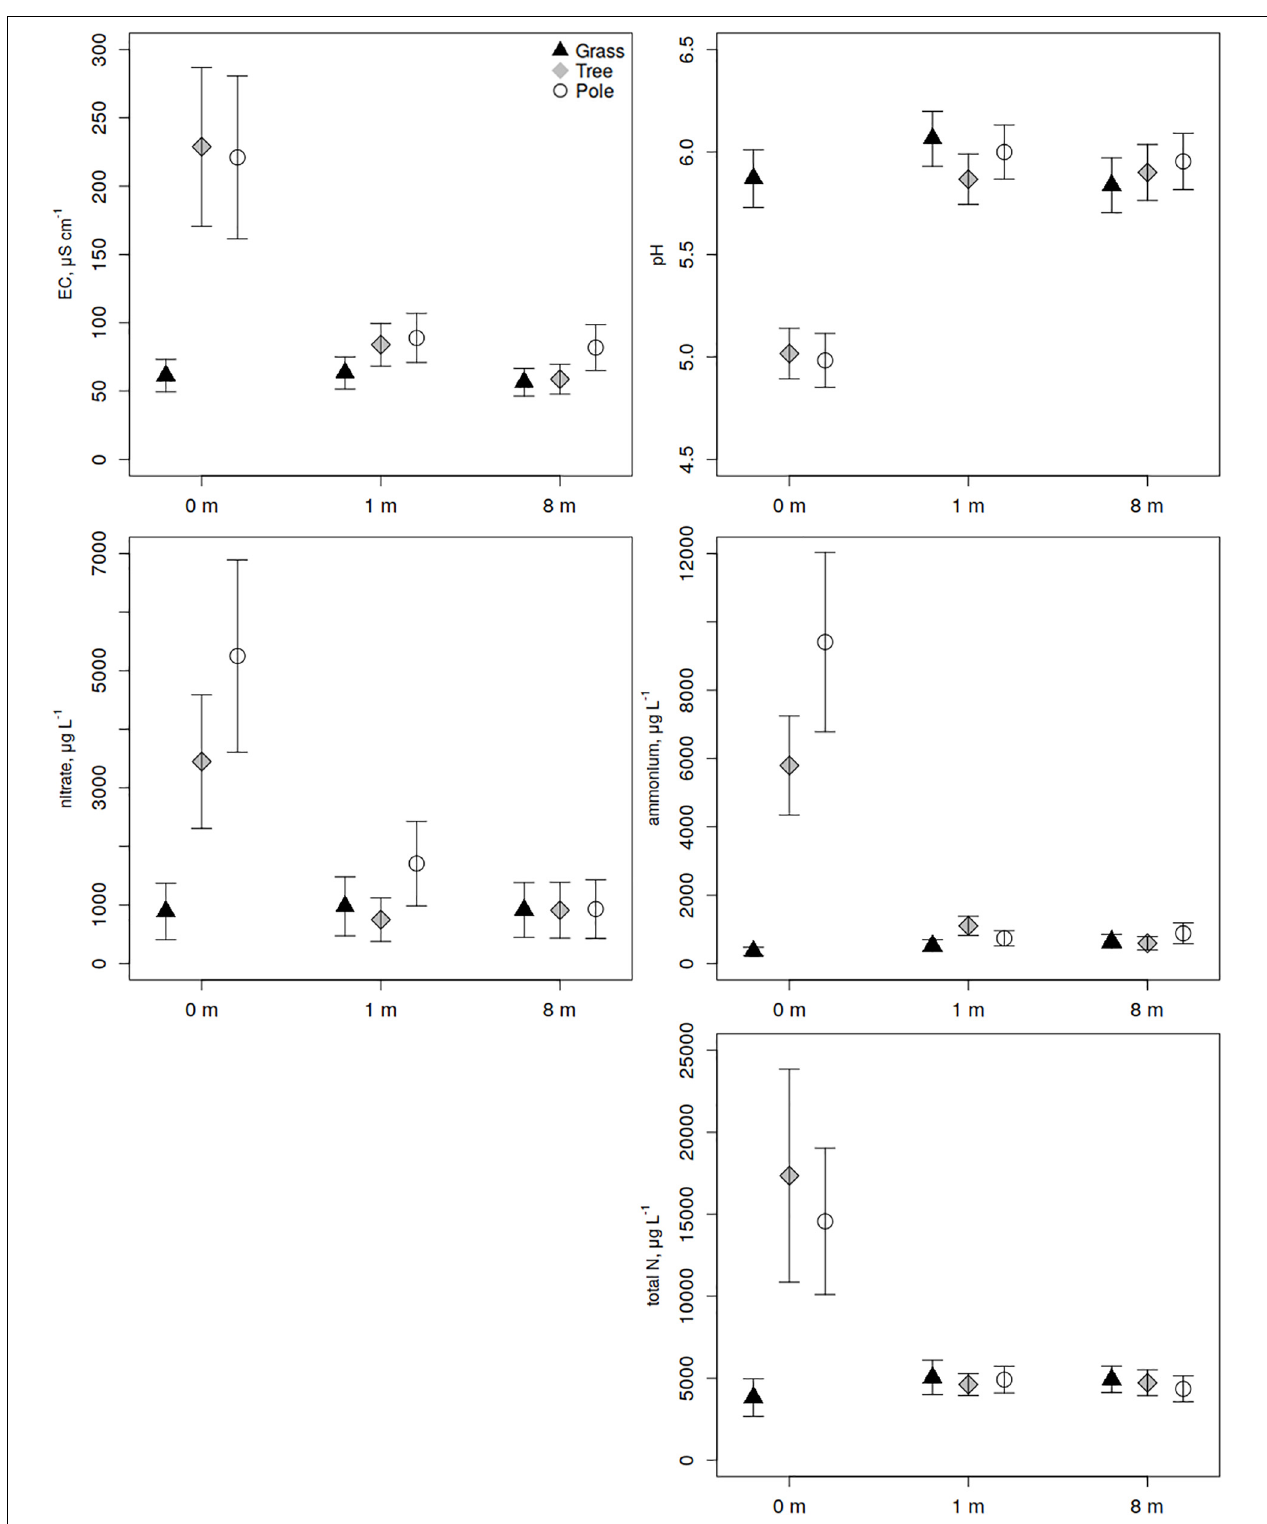
FIGURE 1 | Back-transformed model predicted mean ± SE values for Electrical Conductivity (EC), pH, nitrate, ammonium, and total nitrogen at 0, 1, and 8 m away from path-side grass plots, trees, and poles in Parks only.